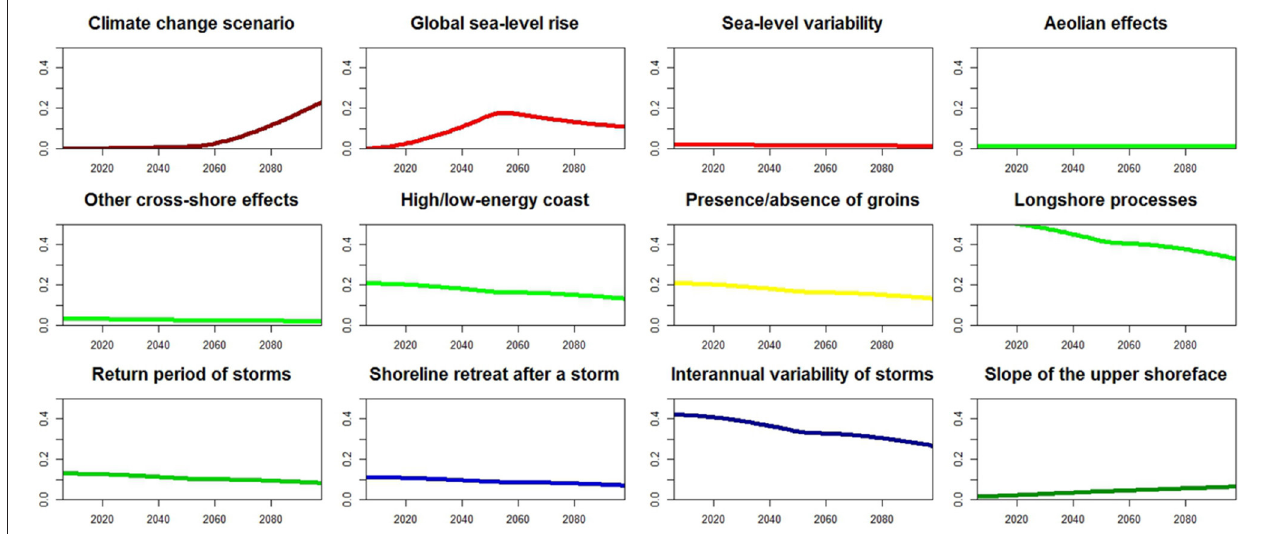
FIGURE 8 | Evolution of the total order Sobol’ indices over the time, indicating which parameter can be fixed to any possible values without much impact to the variance of the model outcome. Please refer also to the legend of Figure 7 for explanations on the colors and inflexions of the